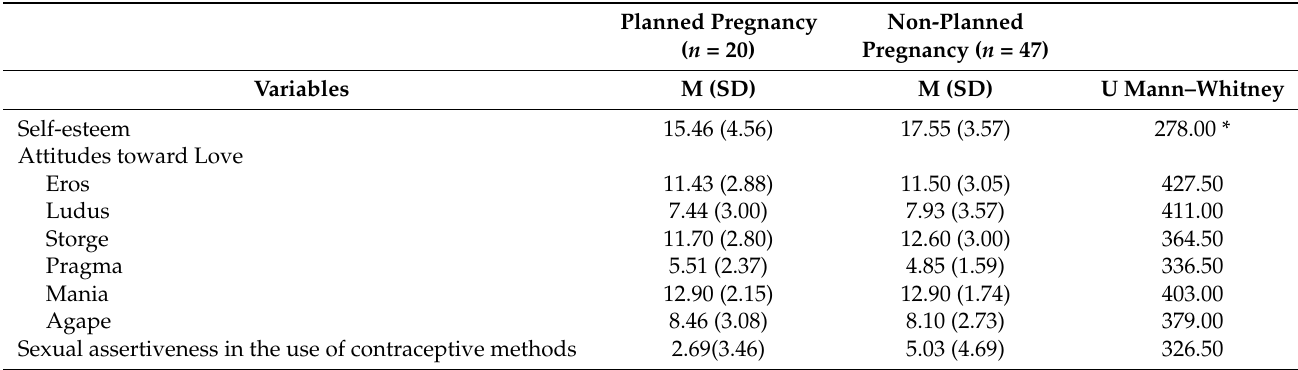
Table 2. Descriptive statistics and comparison in self-esteem, attitudes toward love, and sexual assertiveness between planned and non-planned pregnant adolescents.